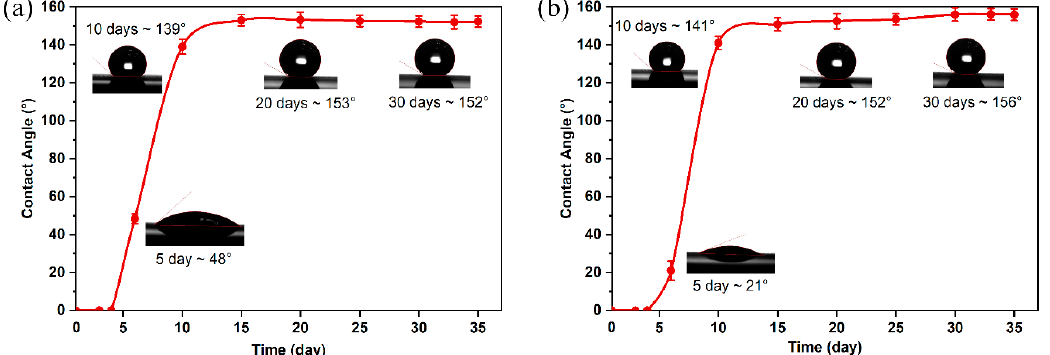
Figure 4. Variations of apparent contact angles (APCAs) for the as-fabricated surfaces with ( a ) line-patterned structure and ( b ) grid-patterned structure.